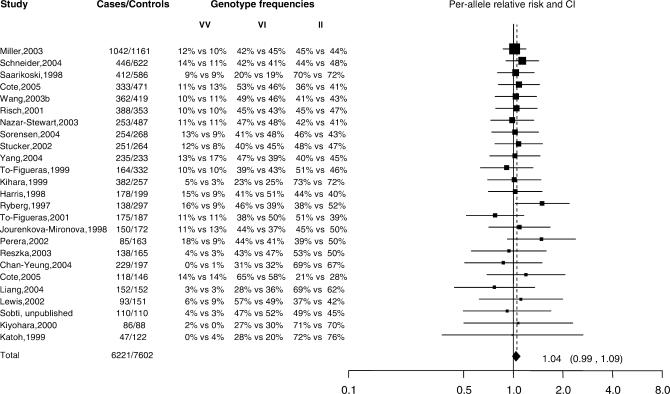
Meta-Analysis of Studies of
GSTP1 I105V Polymorphism and Lung Cancer
The horizontal axis is plotted on a log doubling scale.